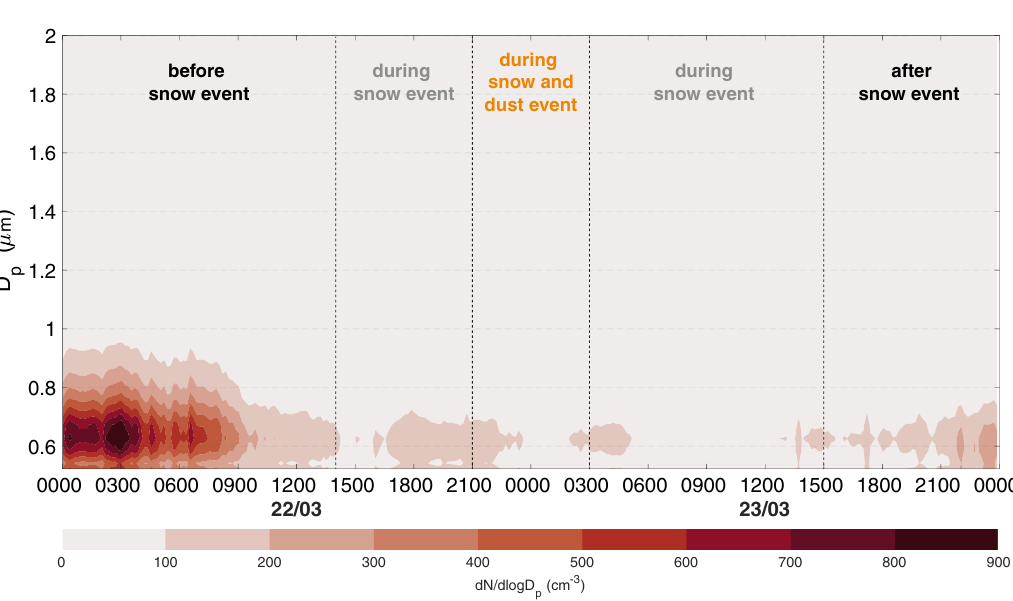
Figure 6. The variations of temperature ( ◦ C, red line) and dew point temperature ( ◦ C, blue line) between 22–23 March as recorded at the Filaret (Bucharest) weather station part of the Romanian network of surface stations. The period with snow at the Filaret station (22 March 1400 UTC–23 March 1500 UTC) is indicated by the green bars for light and continuous snow, and moderate and continuous snow. The concentration of the PM 10 and PM 2.5 is indicated on the top for the period before the beginning of the snow (black, 21 March 1400 UTC–22 March 1400 UTC), during the snow but before the dust intrusion was observed over Bucharest (gray, 22 March 1400 UTC–2100 UTC), during the snow and dust intrusion episode (orange, 22 March 2100 UTC–23 March 0300 UCT), during the snow event but after the dust intrusion over Bucharest (gray, 23 March 0300 UTC–1500 UTC), and after cessation of snow (black, 23 March 1500 UTC–24 March 1500 UTC).